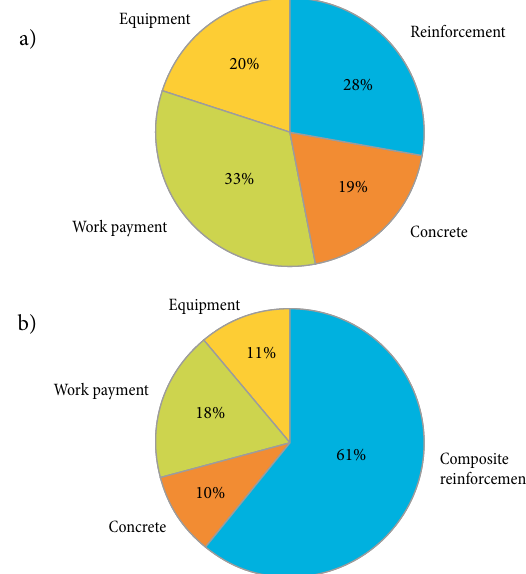
Fig. 7. Production cost distribution of ordinary concrete columns reinforced with steel bars (a) and columns reinforced with GFRP bars